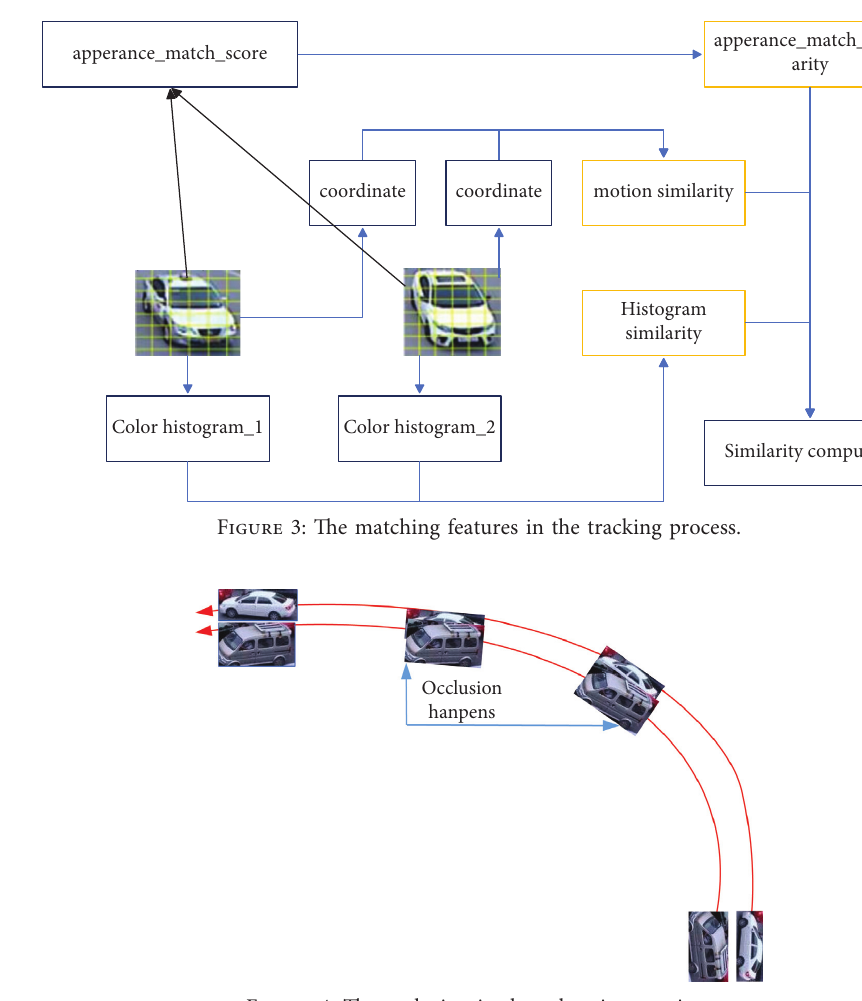
Figure 4: The occlusion in the urban intersection.